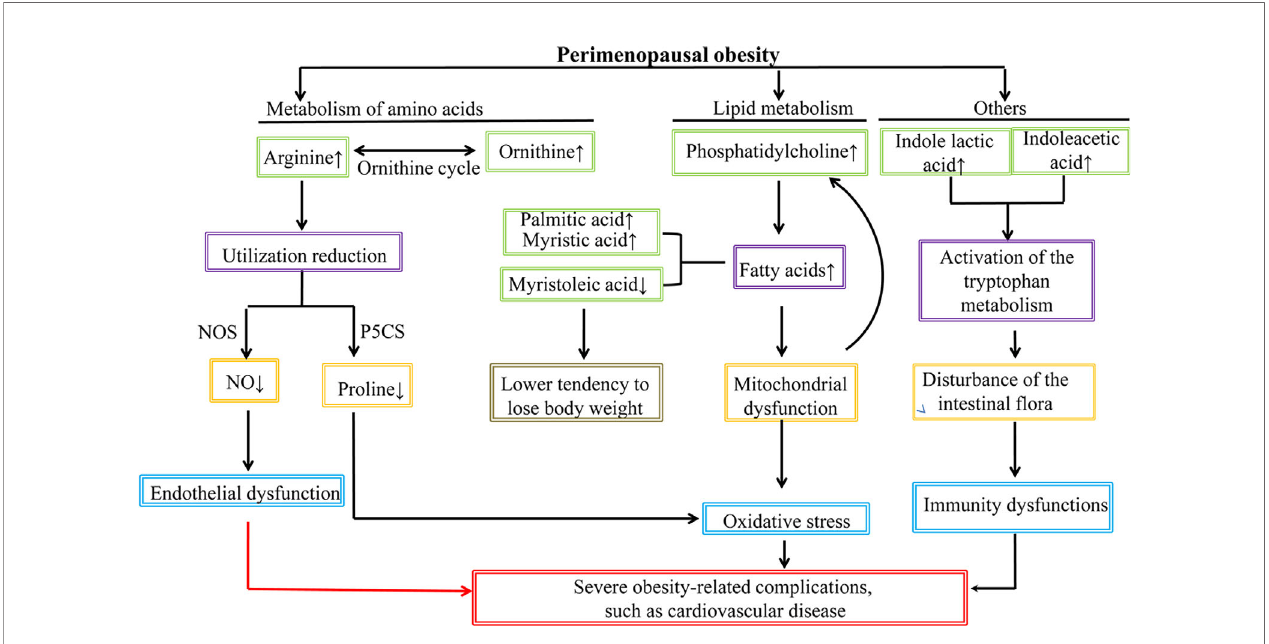
FIGURE 6 | The pathophysiological scenario of perimenopausal obesity summarized in the present